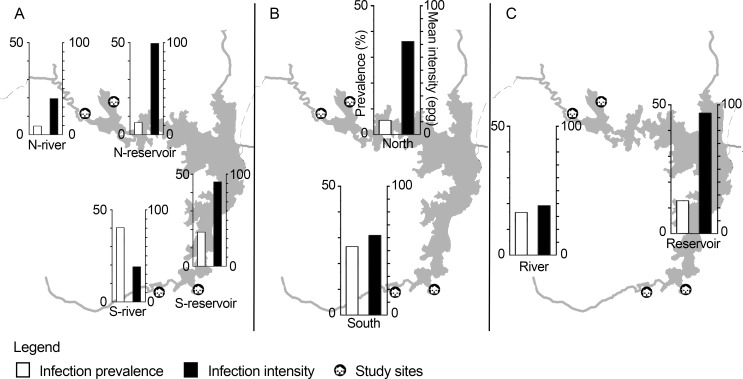
Spatial variation in O. viverrini infection prevalence and mean infection intensity.Comparison of infection prevalence and mean intensity by (A) villages, (B) provincial health jurisdictions, and (C) waterbody types.